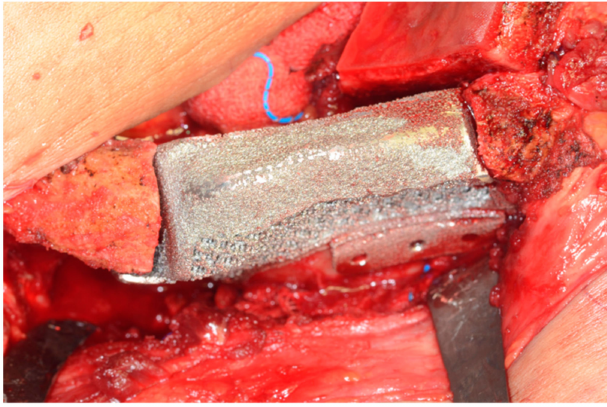
Figure 4. The 3D-printed titanium implant applied for iliac crest reconstruction. Postoperative CT images were taken, and we fused the 3D model with the preoperative CT. The contours of the mandible and iliac crest were matched between the preoperative and postoperative states (Figure 5).